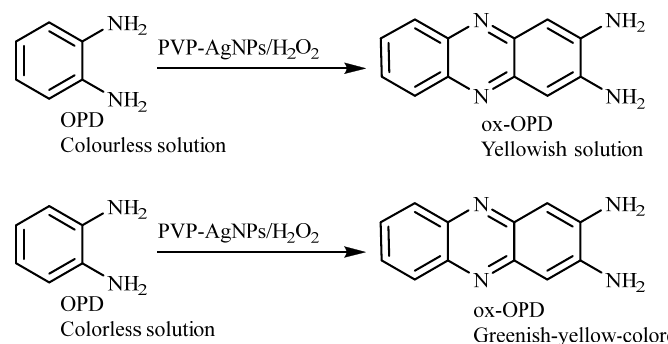
Figure 5. Absorbance spectra; ( a ) PVP-AgNPs/OPD/H 2 O 2 , ( b ) PVP-AgNPs/OPD/H 2 O 2 in the presence of Hg 2+ (0.6 µM), ( c , d ) the blank contents (OPD/H 2 O 2 and/or PVP-AgNPs).